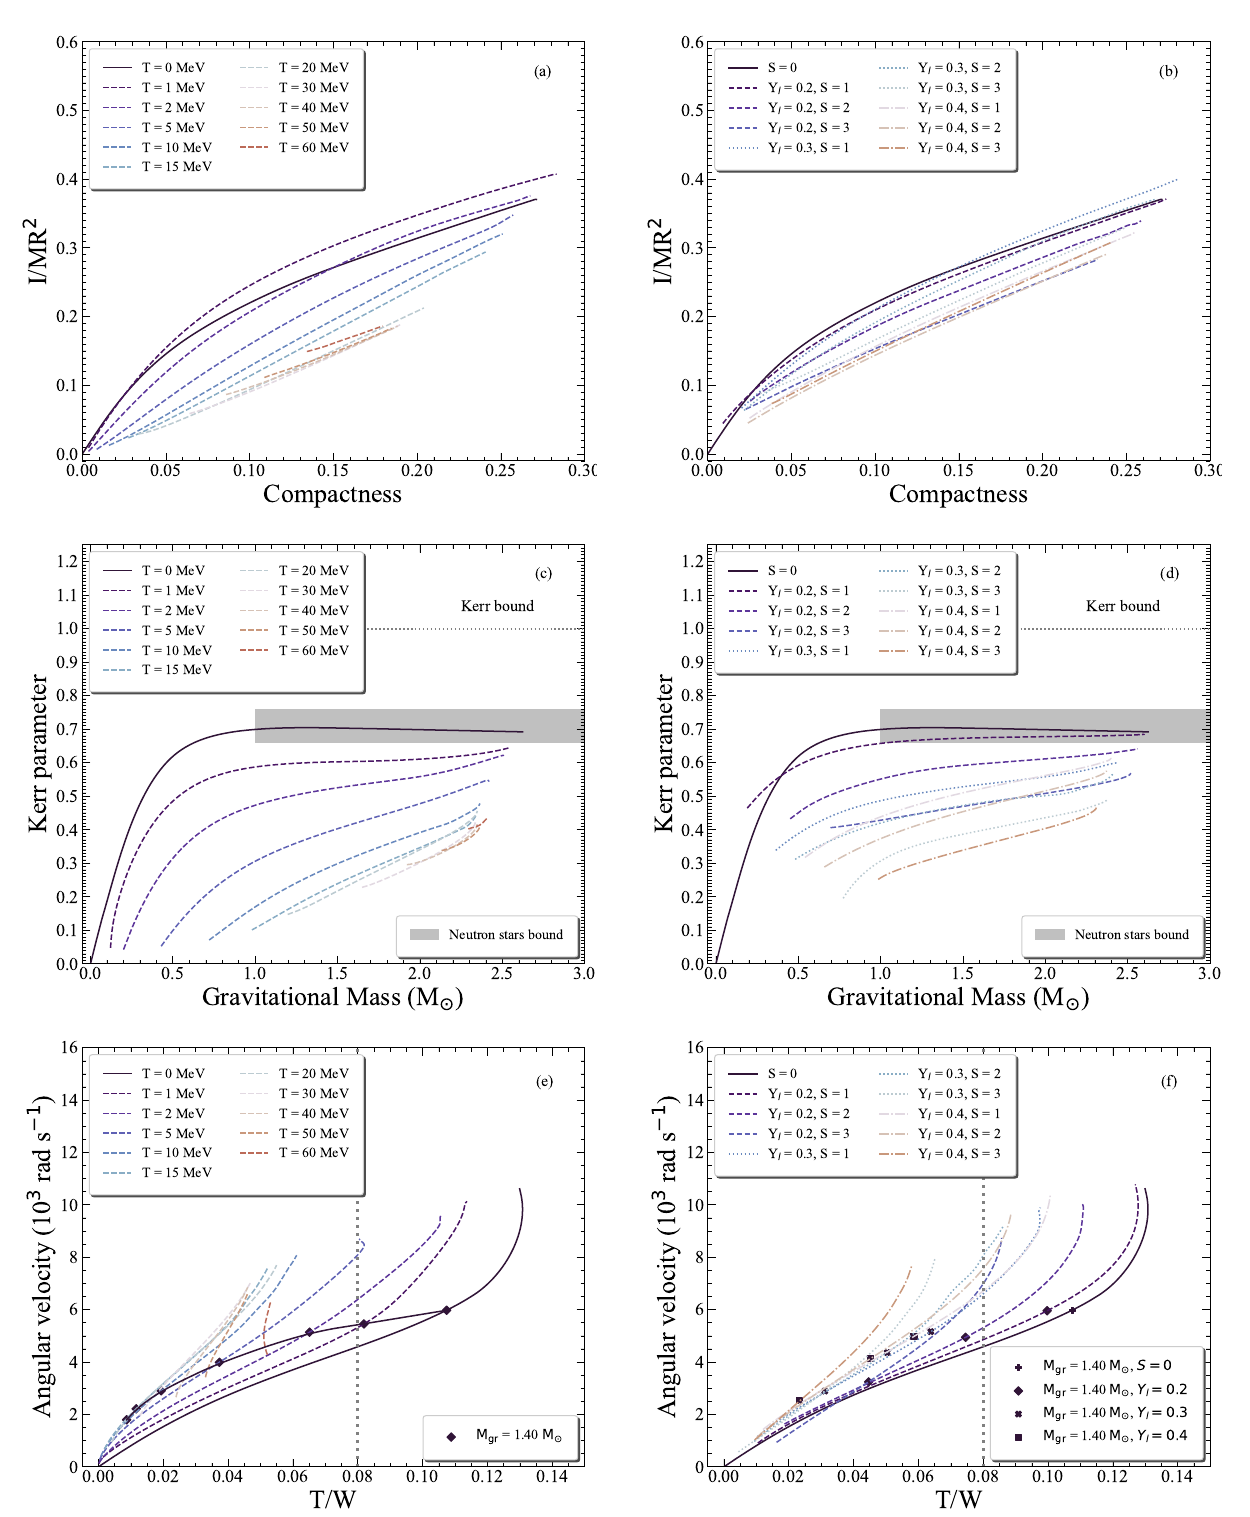
Figure 5. (a,b) The dimensionless moment of inertia as a function of the compactness parameter for (a) isothermal and (b) isentropic neutron stars at the mass-shedding limit. (c,d) The Kerr parameter as a function of the gravitational mass for (c) isothermal and (d) isentropic neutron stars at the mass-shedding limit. The horizontal dotted line marks the Kerr bound for astrophysical Kerr black holes, K = 0 . 998 [19]. The shaded region represents the limits for neutron stars from Equation (4). (e,f) The angular velocity as a function of B . H . the ratio of rotational kinetic to gravitational binding energy for (e) isothermal and (f) isentropic neutron stars at the mass-shedding limit. The vertical dotted line marks the critical value, T / W = 0 . 08 [20], for gravitational radiation instabilities. Black plus sign, diamonds, squares, and crosses represent the M gr = 1 . 4 M (cid:3) configuration. For all Figures, the cold configuration is presented with the solid line while hot configurations, with the dashed